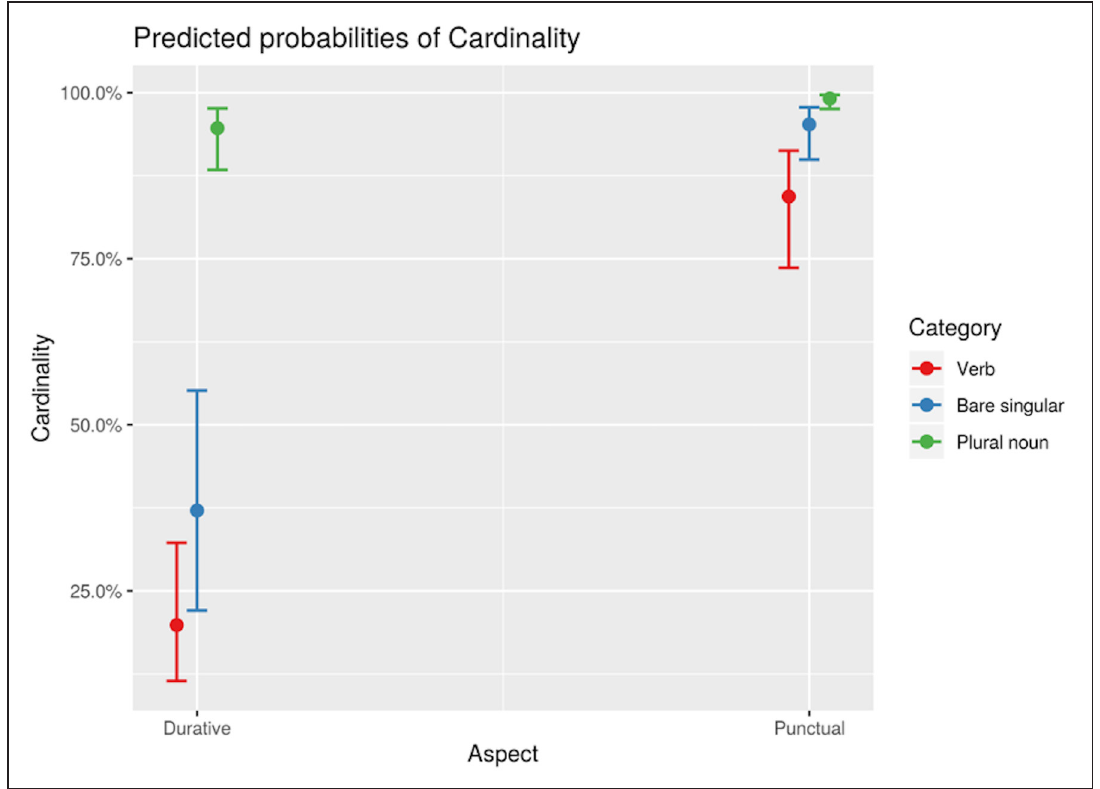
Figure 4: Predicted probabilities of cardinality responses in the interaction between durative and punctual aspectual features and the categories of verbs, bare singulars and plural